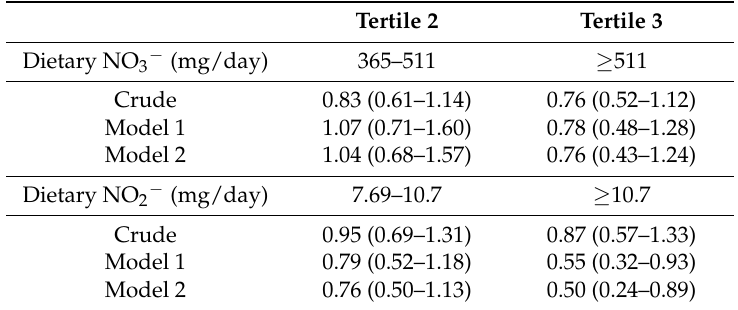
Table 4. The association of dietary nitrate and nitrite intakes and the risk of chronic kidney disease (CKD) after 6-years of follow-up: Tehran Lipid and Glucose Study 2006–2008 to